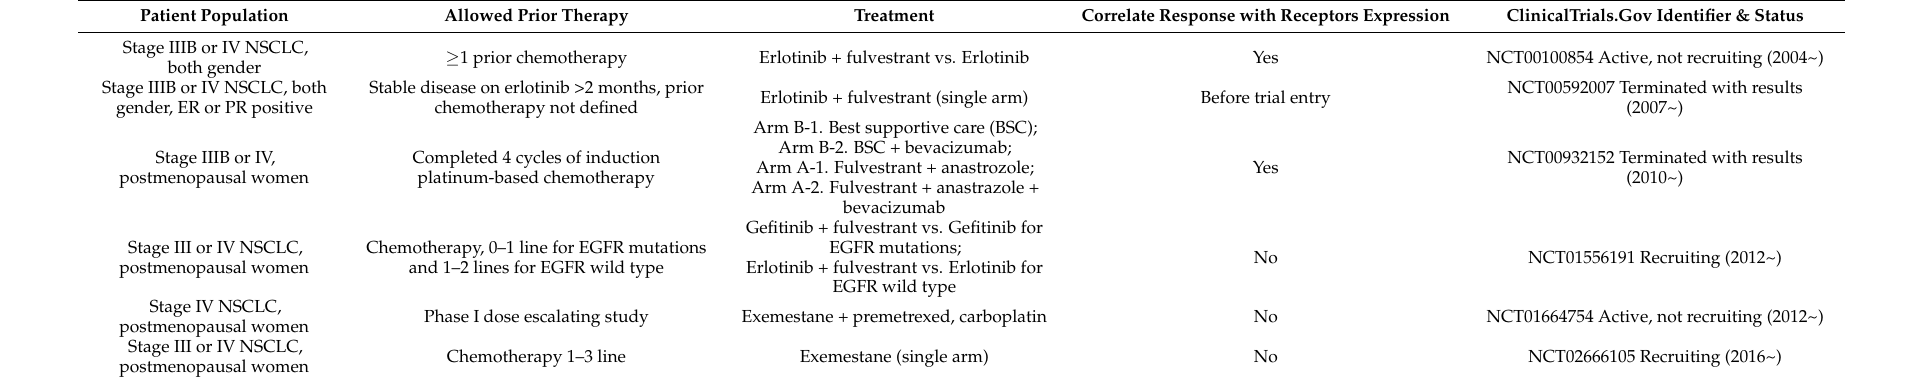
Table 2. Clinical trials of hormone therapy in advanced NSCLC (http://www.clinicaltrial.gov/, accessed on 11 June